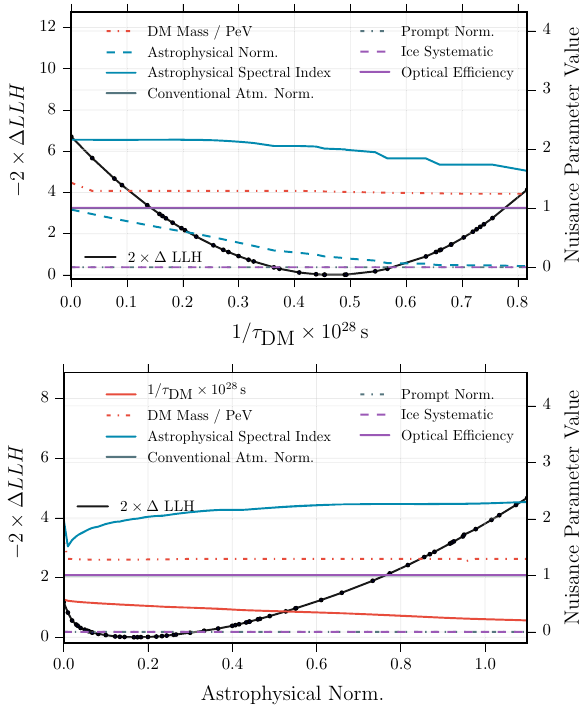
Fig. 6 Track analysis: profile likelihood scans of the inverse dark mat- ter lifetime (proportional to the signal strength) and the diffuse astro-